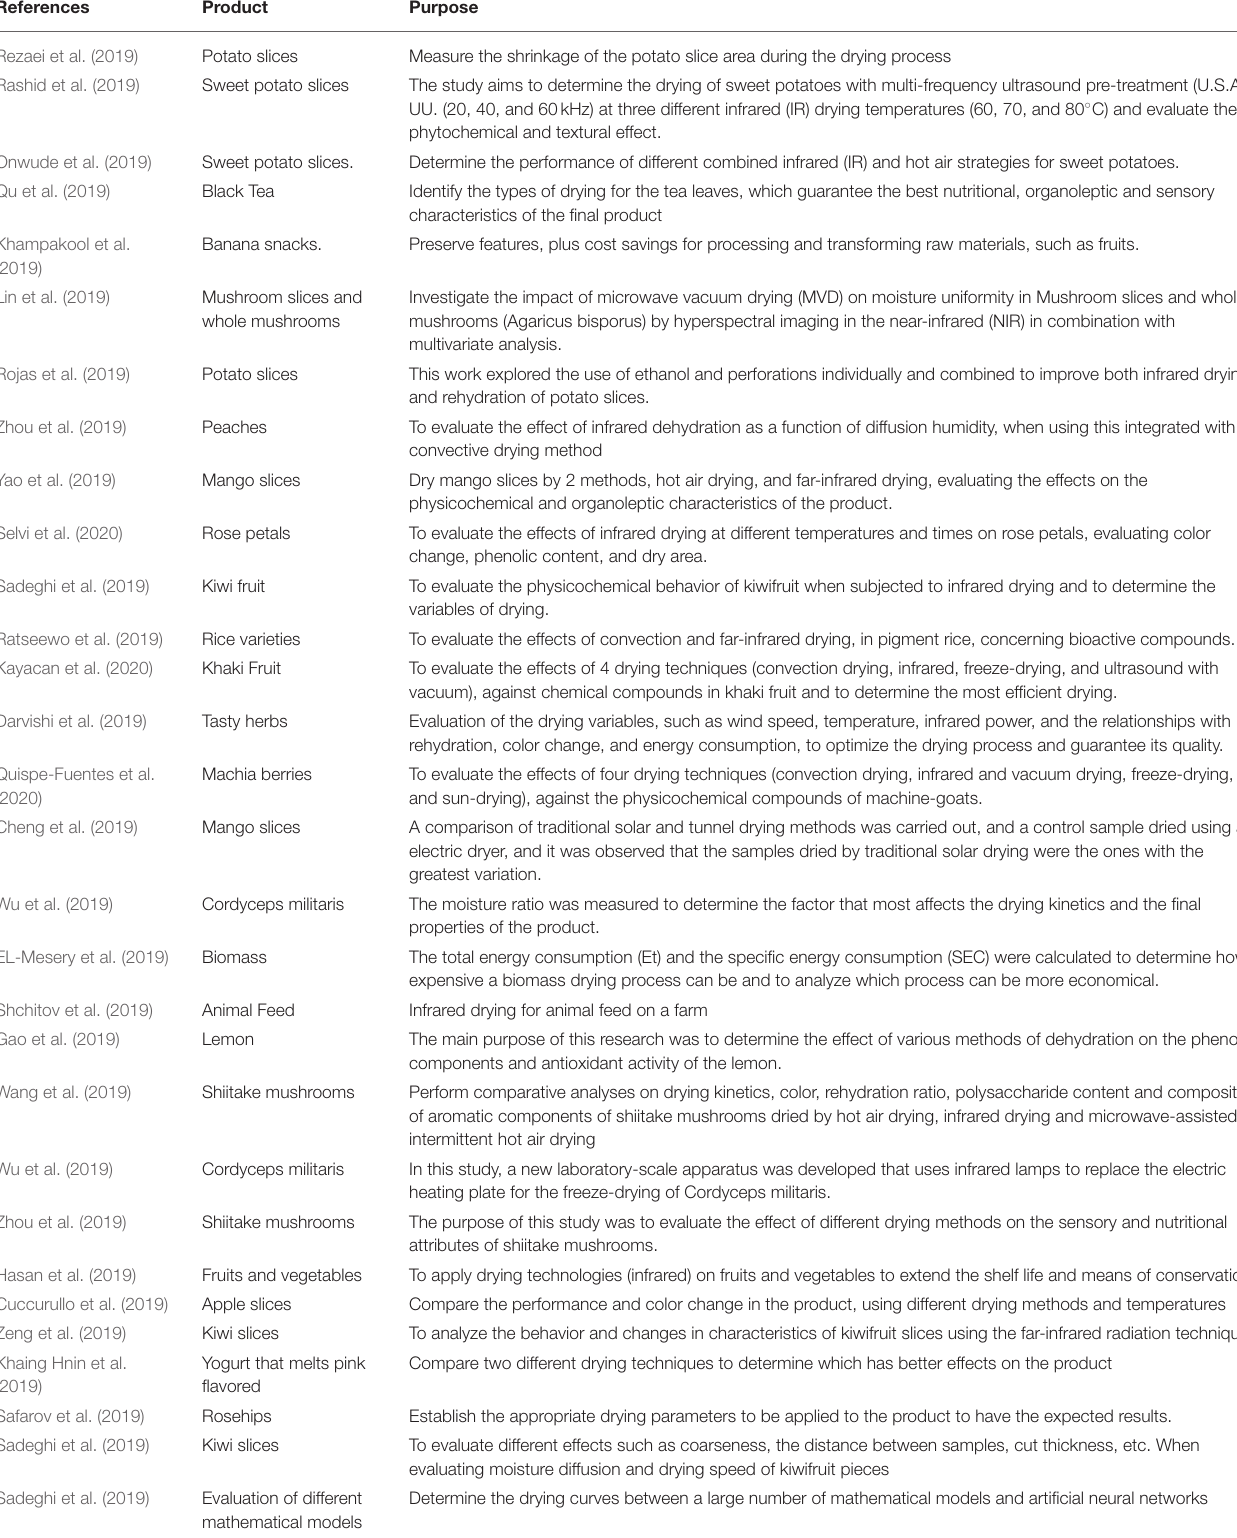
TABLE 1 | Identification of products worked by each